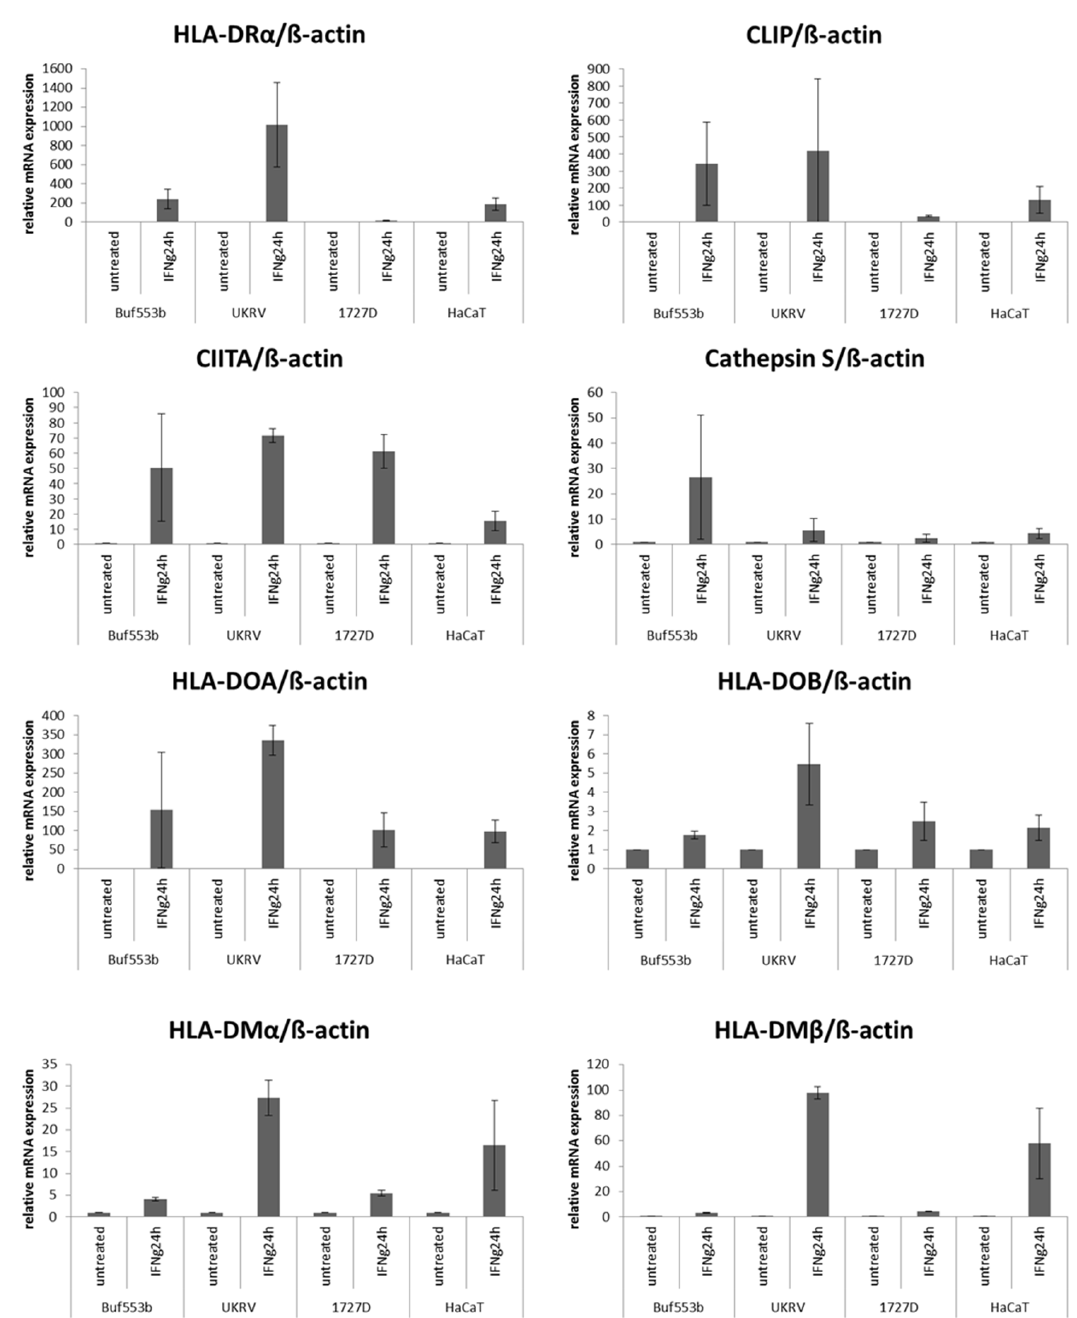
Figure 3. Link of IFN- γ -mediated upregulation of HLA class II surface expression with HLA class II APM components. The expression of HLA class II APM components of selected untreated and IFN- γ treated (24 h) melanoma cell lines was determined by qPCR. The data were normalized to β -actin expression, and relative mRNA expression was presented as bar charts by setting mRNA transcript levels of untreated cells to 1.